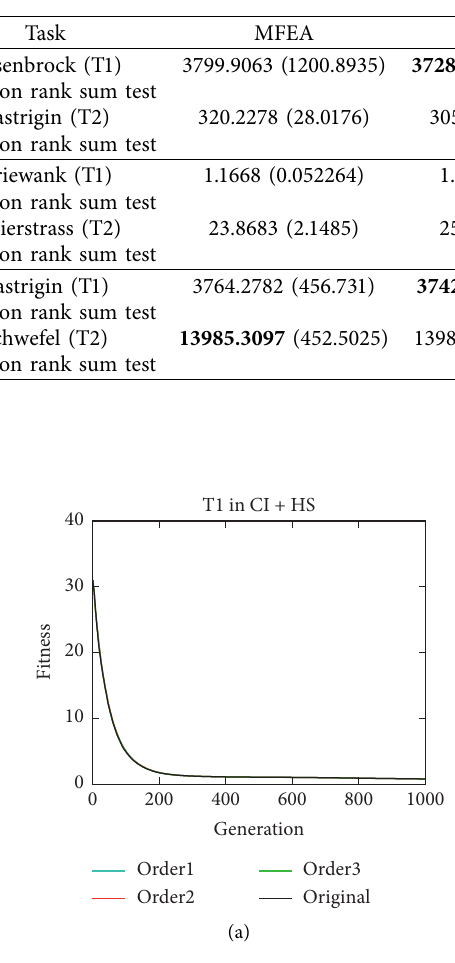
Figure 4: Convergence of MFEA for problem 1 (CI+HS).